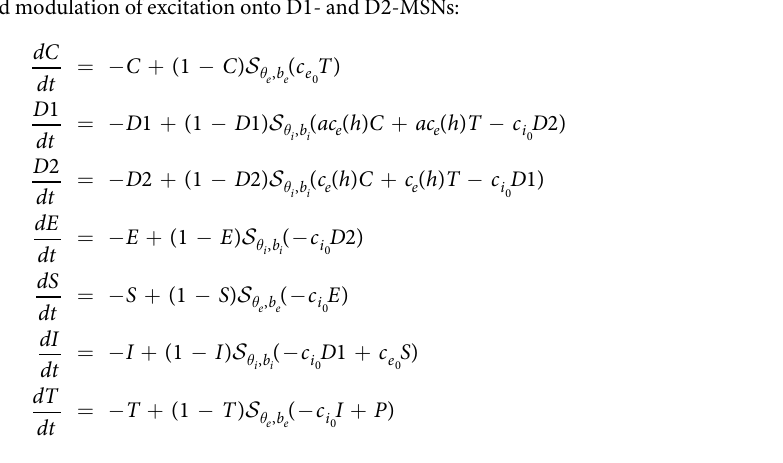
proportionately onto D1- and D2-MSNs (using the parameter h ). Second , we scale these effects differently in D1- and D2-MSNs (using the parameters a and b ). Effect of local and coupled changes in the excitation of D1- and D2 -MSNs. We use the following system to study the effect of a coupled modulation of excitation onto D1- and D2-MSNs: = − + − , = − + − + − ,